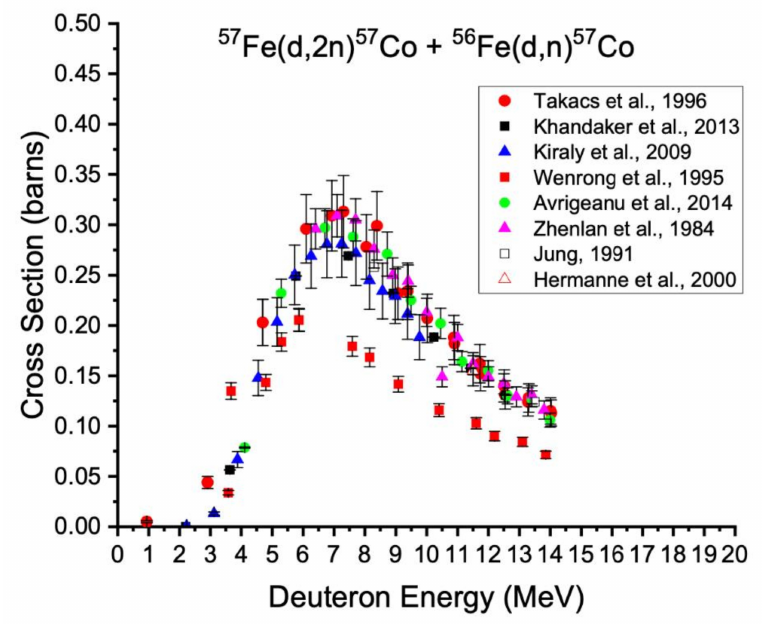
Figure 7. Excitation functions for the production of cobalt-57 from the 57 Fe(d,2n) and 56 Fe(d,n) nuclear reactions